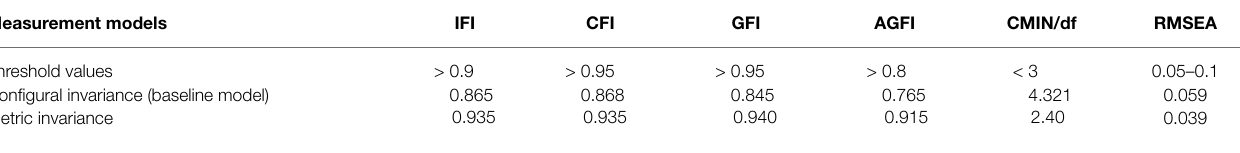
TABLE 2 | The analysis of model fit (metric invariance).